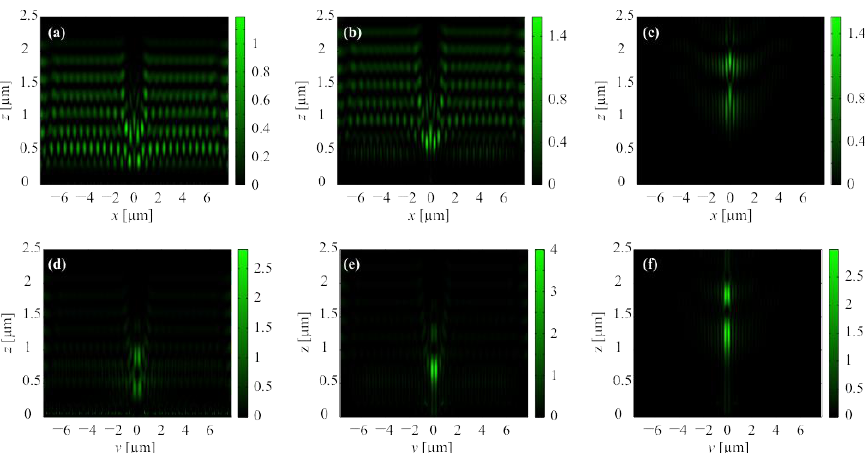
Figure 9. The instantaneous longitudinal of the intensity of the second-order CVB focused by gold BZP pattern in XZ-plane ( a – c ) and YZ-plane ( d – f ) at the time moment of 95.06 fs ( a , d ), 109.08 fs ( b , e ), and 183.13 fs ( c , f ).